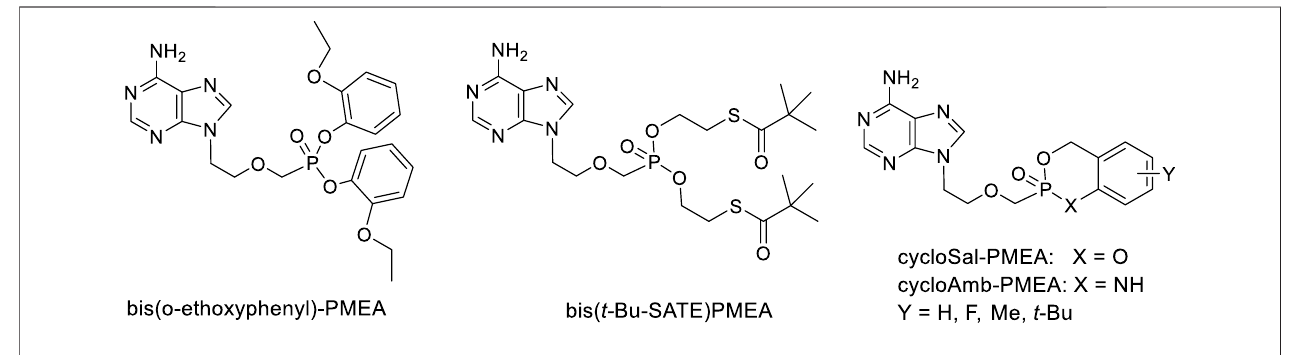
FIGURE 5 | Alternative prodrugs of